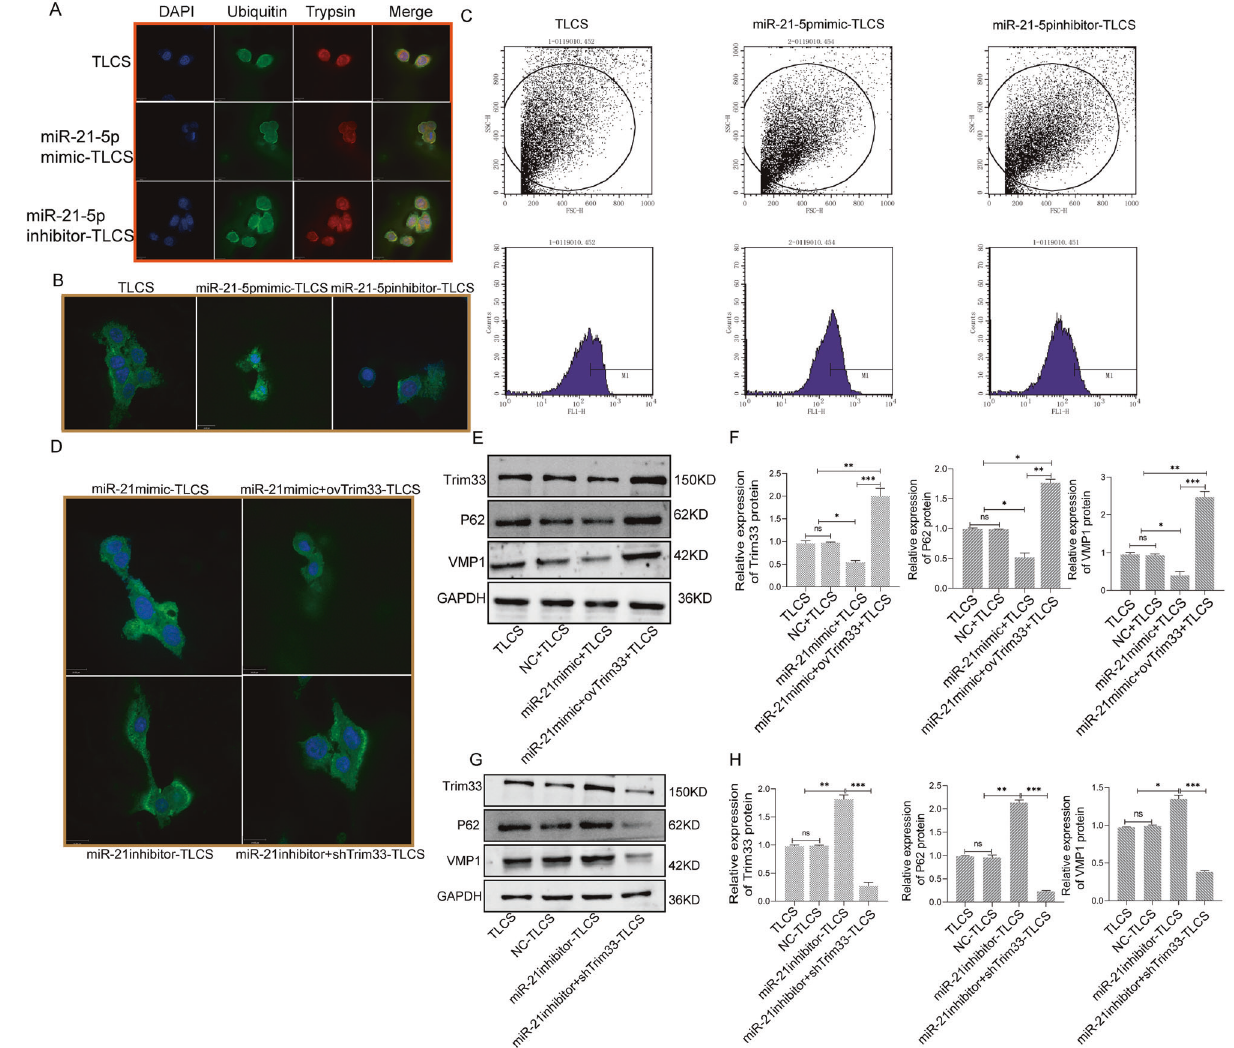
Fig. 7 miR-21-5p inhibits zymophagy by regulating Trim33. A Co-localization analysis of endogenous ubiquitin and zymogen particles. B The photos of the activation of each group of zymogen particles were taken by a confocal microscope. C Flow cytometry to detect the fl uorescence intensity value of each group. D Detect the activation level of zymogen in each group. E – H The mRNA and protein levels of VMP1,Trim33 and P62 in each group were detected by RT-PCR and Western blot ( t -test, *** p < 0.001, ** p < 0.01, * p <